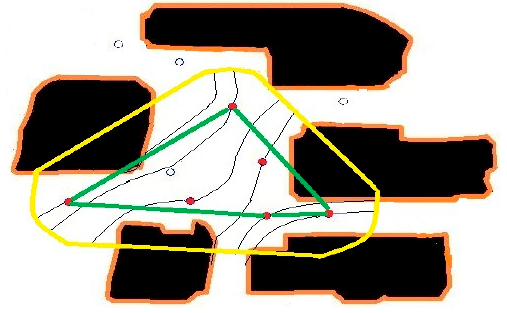
Figure 16. The map of particle paths using six sensors.